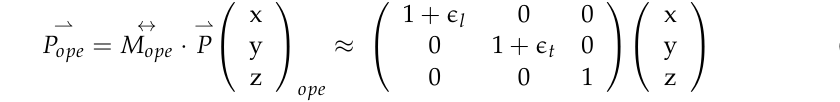
Figure 1. Dynamical stretching geometry of the uniaxial flexible NPR microstructure mold.